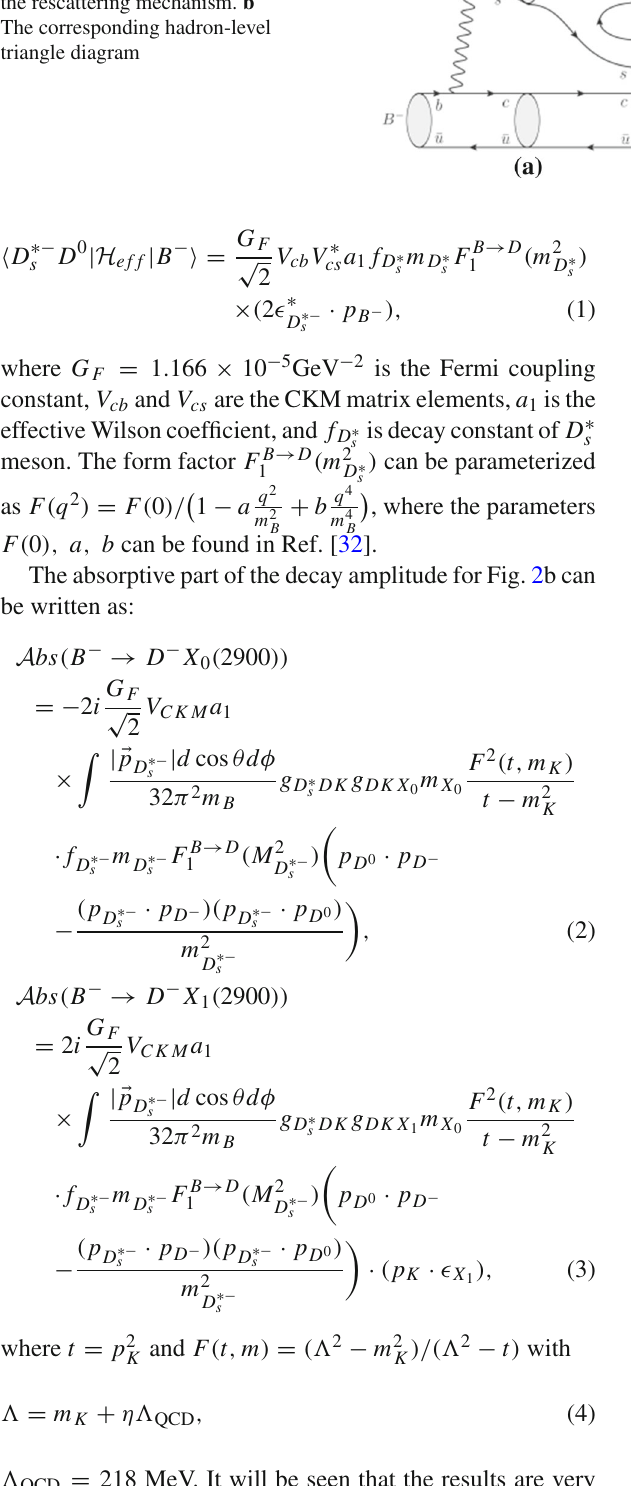
Fig. 2 a Quark-level diagram of B − → D − X 0 , 1 ( 2900 ) within the rescattering mechanism. b The corresponding hadron-level triangle diagram